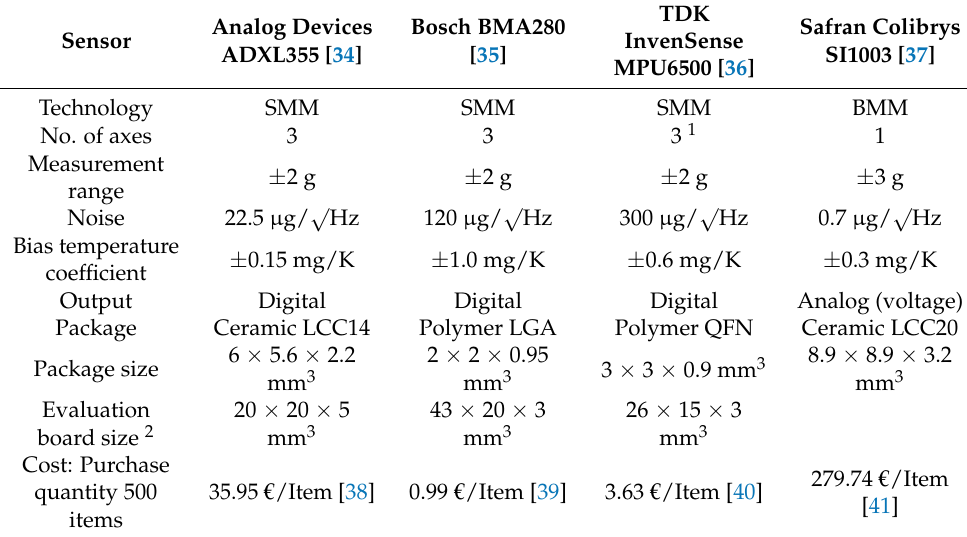
Table 1. Commercial silicon MEMS acceleration